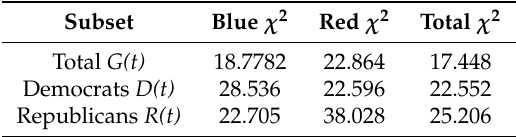
Table 4. The χ 2 fit for the overall voting record G(t) , Democrats D(t) , and Republicans R(t) by color (R,B). This demonstrates the degree of the triangle bias for each pre-defined classification.